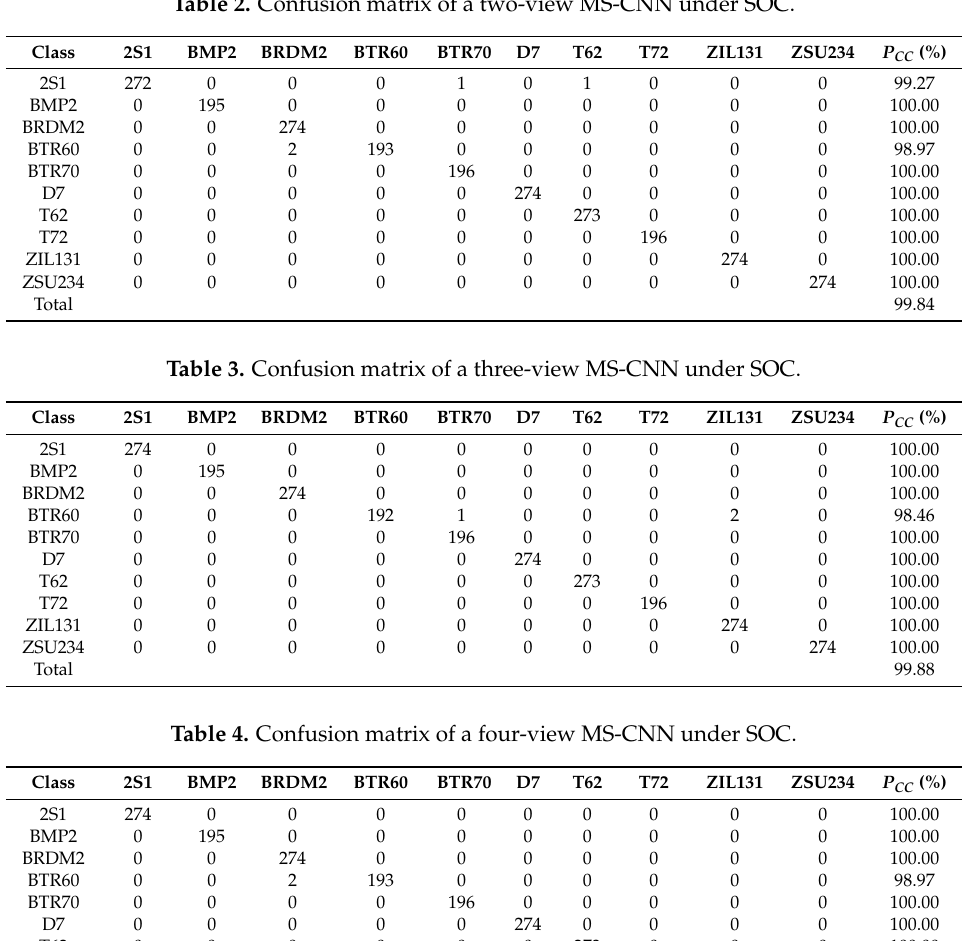
Table 2. Confusion matrix of a two-view MS-CNN under SOC.